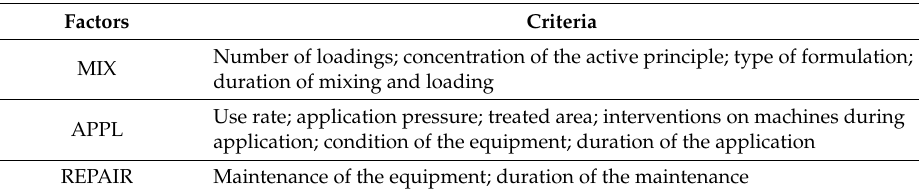
Table 2. Criteria used in the algorithm proposed by the Agricultural Health Study